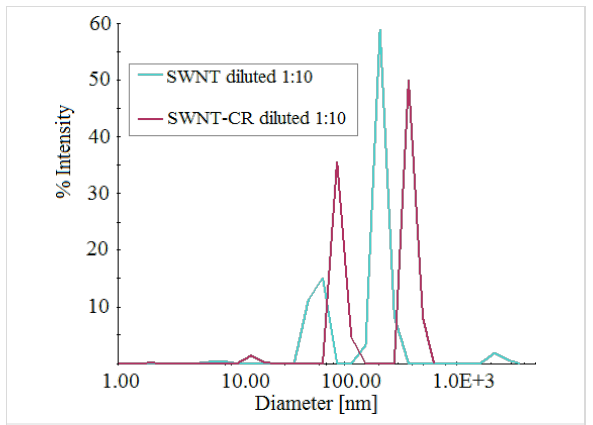
Figure 8: Dynamic light scattering (DLS) measurements: comparison of SWNT–CR complexes and sodium cholate dispersed SWNTs